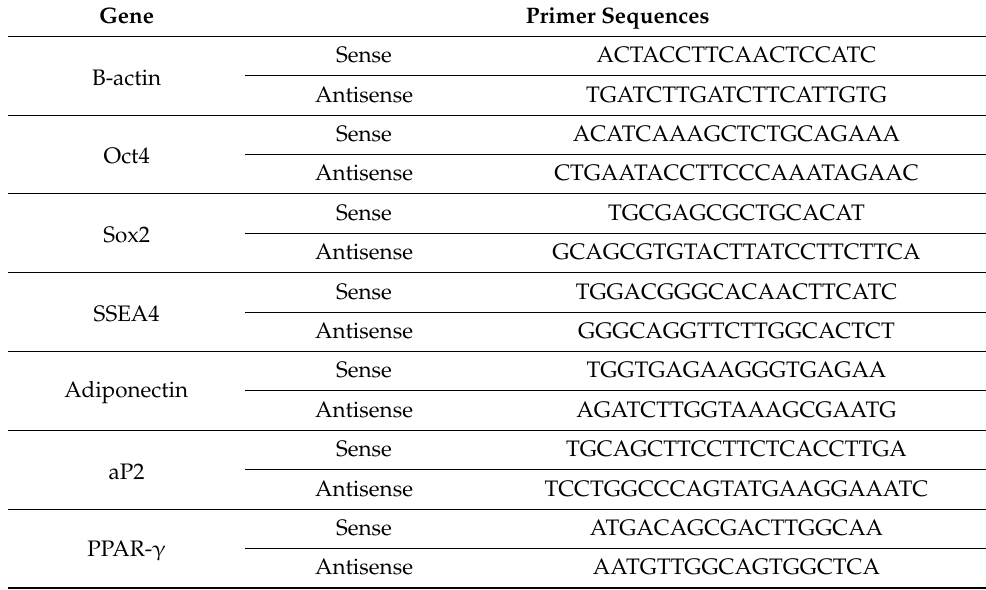
Table 1. Sequences of primers used in the qRT-PCR analysis.